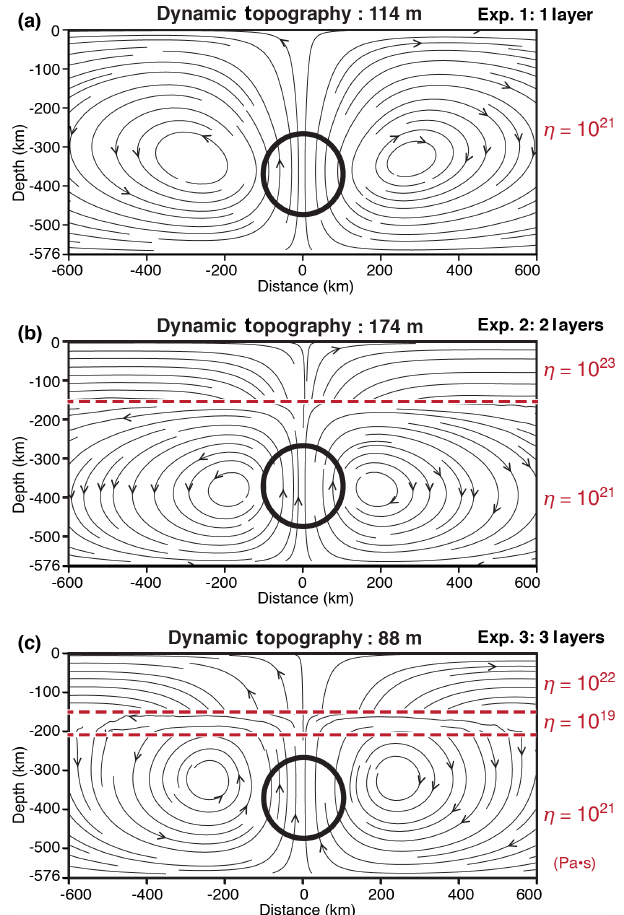
Figure 3. Predicted peak amplitudes of dynamic topography for layered Earth models with isoviscous rheology. Centred at 372km depth, the embedded spherical density anomaly (black circle) is 96km in radius. It has a temperature anomaly of + 324 ◦ C, giving 1% effective density difference with the background. The resulting streamlines are shown in a 2-D cross section ( x − z plane) along the centre of each numerical model ( y = 0km).